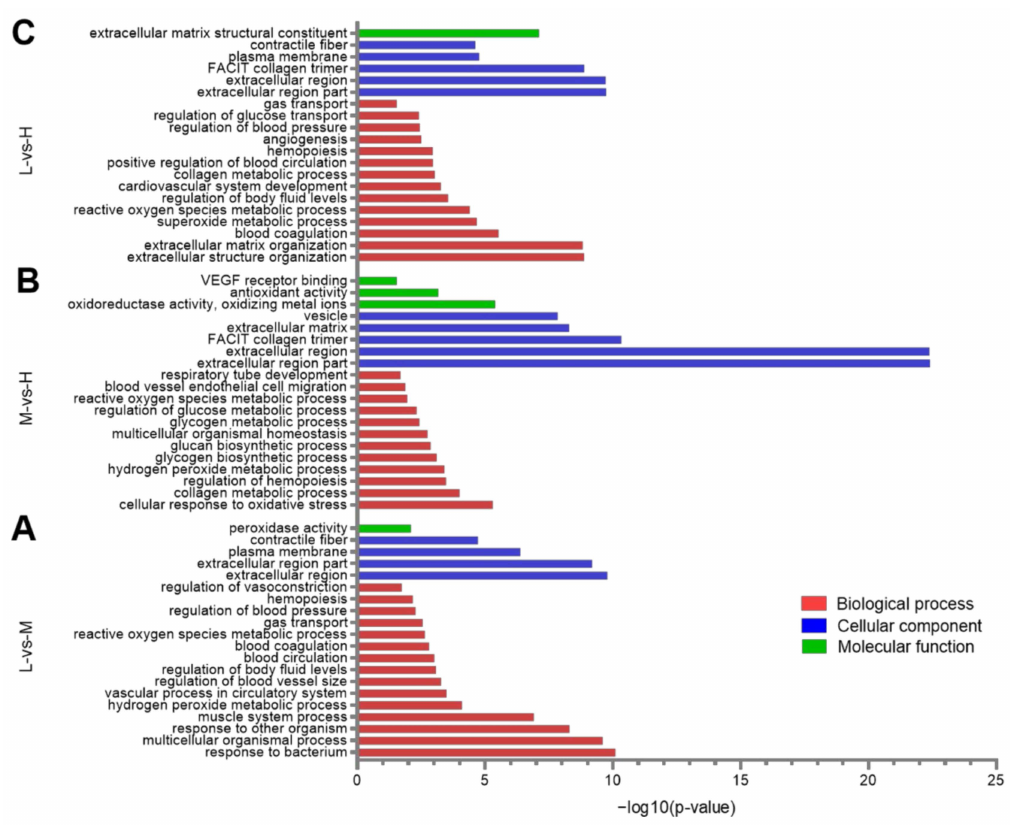
Figure 9. Histogram of Gene Ontology (GO) enrichment classification. A portion of the significantly enriched biological process (BP), cellular component (CC), and molecular function (MF) GO terms are shown, when comparing the DEPs between L-vs-M ( A ), M-vs-H ( B ), and L-vs-H altitudes ( C